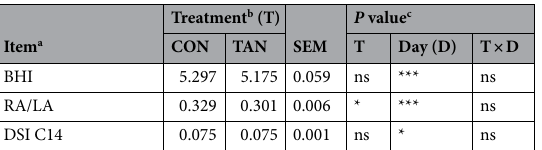
Table 5. Effect of dietary tannin extract on fatty acid profile of milk in dry season experiment. a De novo FA < 16C sum of C4:0, C6:0, C8:0, C10:0, C12:0 and C14:0, SFA saturated fatty acids, MUFA monounsaturated fatty acids, PUFA polyunsaturated fatty acids, OCFA odd-chain fatty acids, BCFA branched-chain fatty acids, BHI biohydrogenation intermediates, DSI C14 desaturation index, calculated as C14:1 c 9/(C14:0 + C14:1 c 9). b CON control group, TAN group receiving 150 g/head × day of tannin extract. c ns ≥ 0.100; † < 0.100; *< 0.050; **< 0.010; ***<